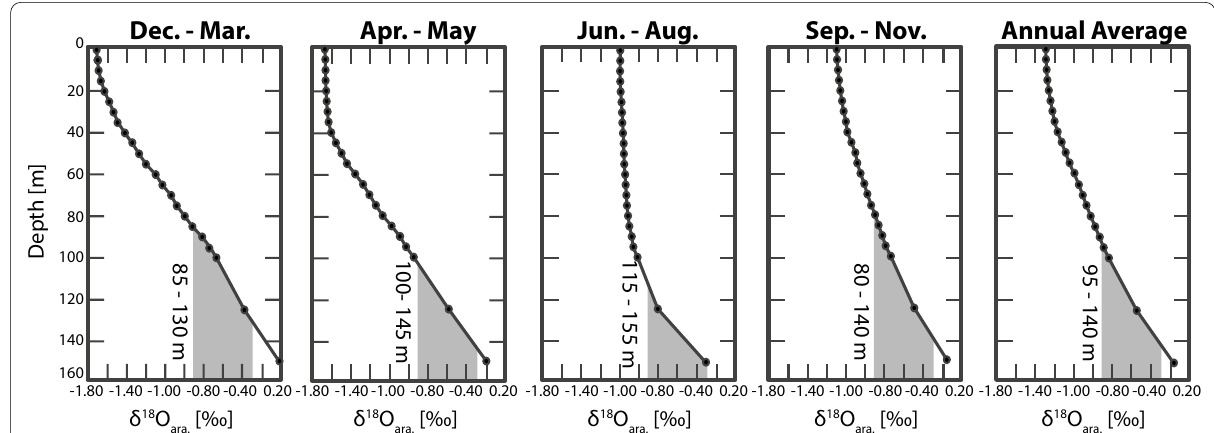
Fig. 7 Seasonal and annual profiles of the theoretical aragonite δ 18 O equilibrium values for Site U1463. A direct comparison with the values measured for H. inflatus (gray bands) indicates calcification depths between 80 and 155 m, with annual averages of 95–140